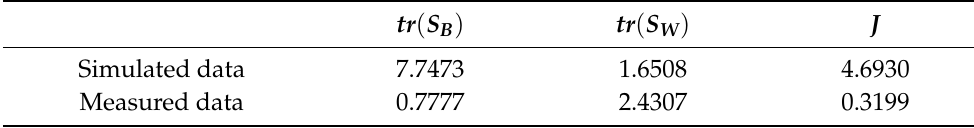
Table 8. The spectral separability of the